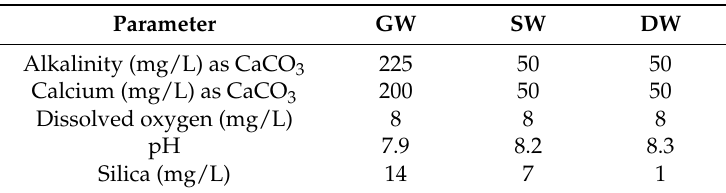
Table 1. Water quality parameters of the source